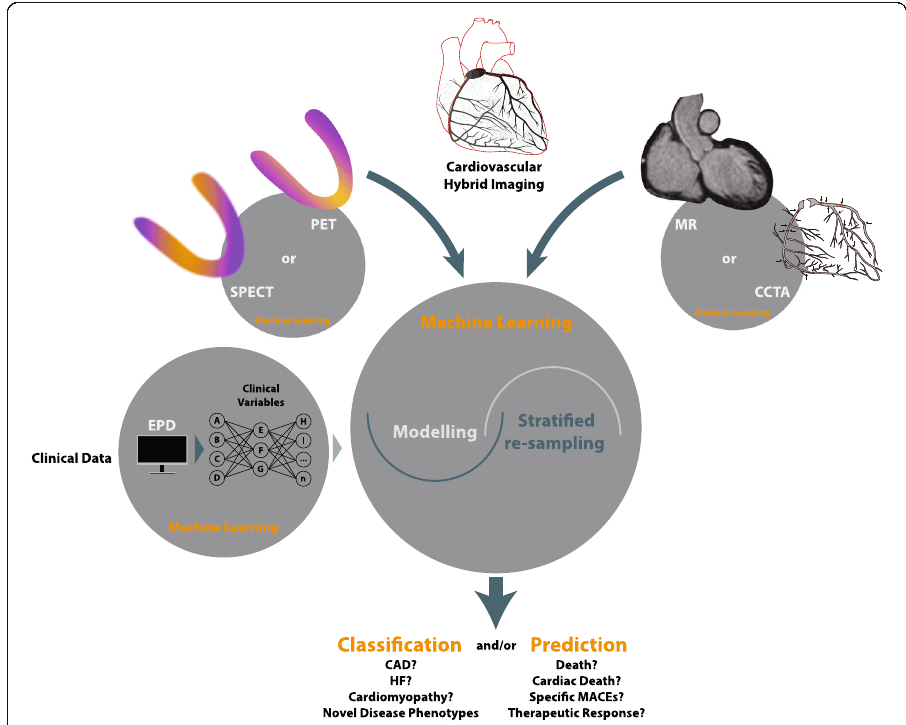
Fig. 5 Areas for implementation of ML algorithms in hybrid cardiovascular imaging. Integration of complex data provided by individual techniques, which can be acquires within the same imaging session, is likely